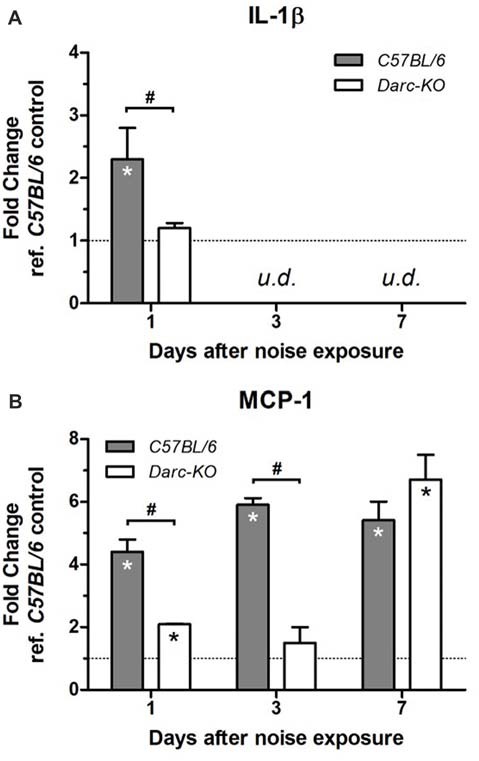
Darc deficiency caused a reduction in the mRNA expression of Il-1β
(A) and Mcp-1
(B) in response to acute noise exposure. Mice were exposed to intense OBN (112 dB SPL, 8–16 kHz, 2 h). Then, cochleae were harvested at 1, 3 and 7 days post-noise exposure, and the expression levels of Il-1β and Mcp-1 were evaluated by Real Time PCR in WT and Darc-KO mice in comparison with WT control mice not exposed to noise. Data are presented as fold change vs. WT control not exposed to noise, in the format of mean ± SEM. n = 3–5, *P > 0.05 vs. control not exposed to noise, #P > 0.05 between the two lines of mice exposed to noise. The expression level of Il-1β was undetectable (u.d.) at 3 and 7 days post-noise exposure.